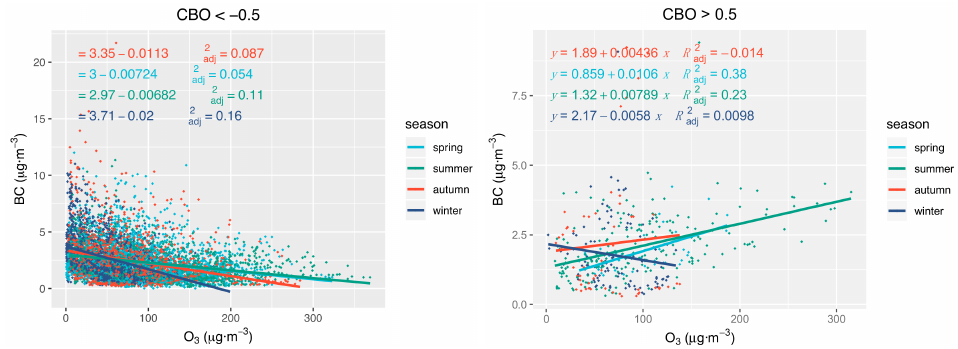
Figure 1. The scatter plot and the linear fit of O 3 and BC concentrations.